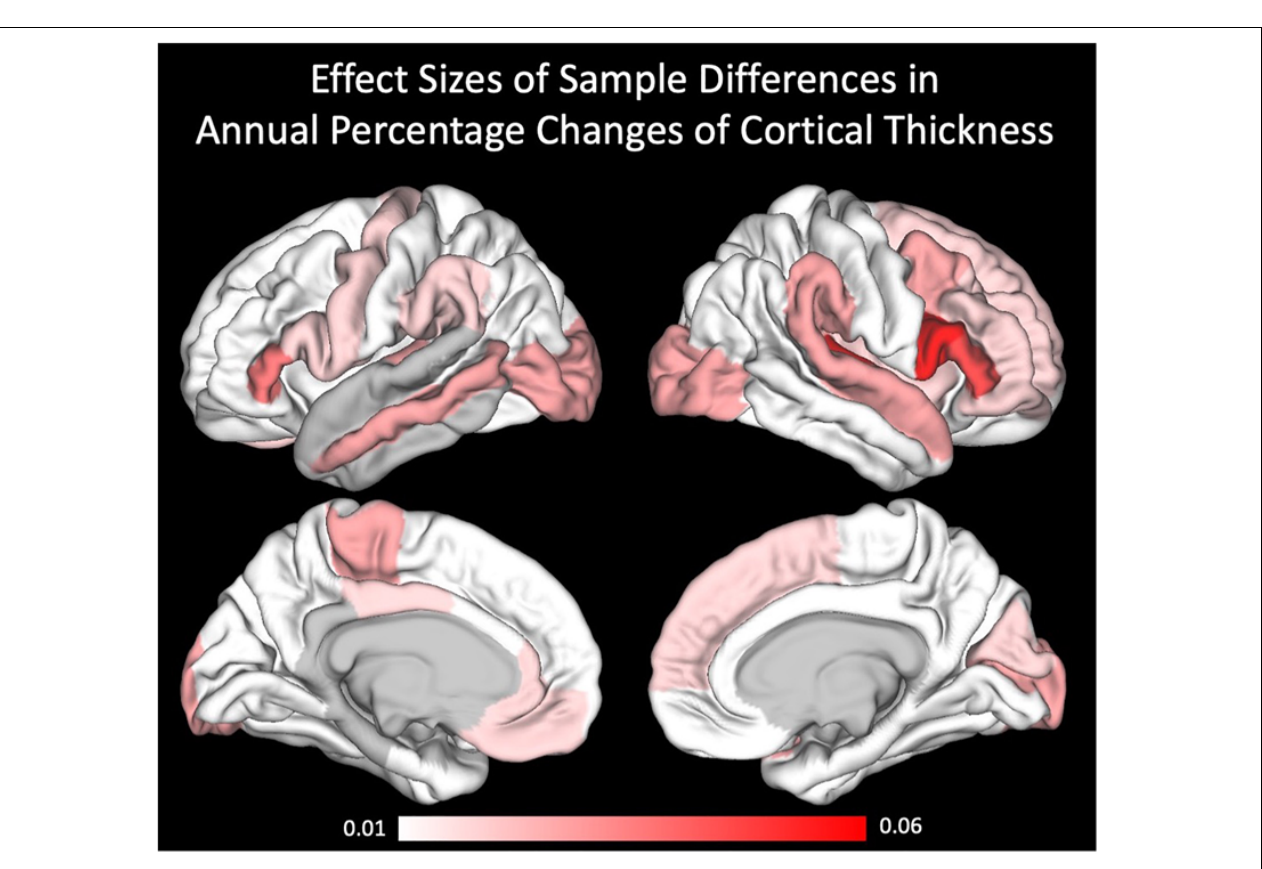
FIGURE 3 | Effect sizes of sample differences using partial eta